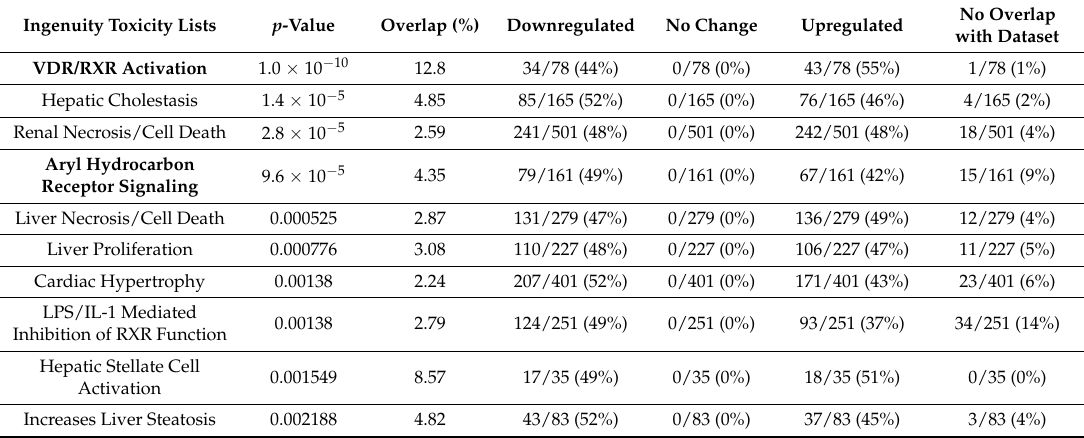
Table 4. Ingenuity toxicity list secondary to keratinocytes treatment with 1,25(OH) 2 D3 in humans for 6 h. Nuclear receptors are marked in